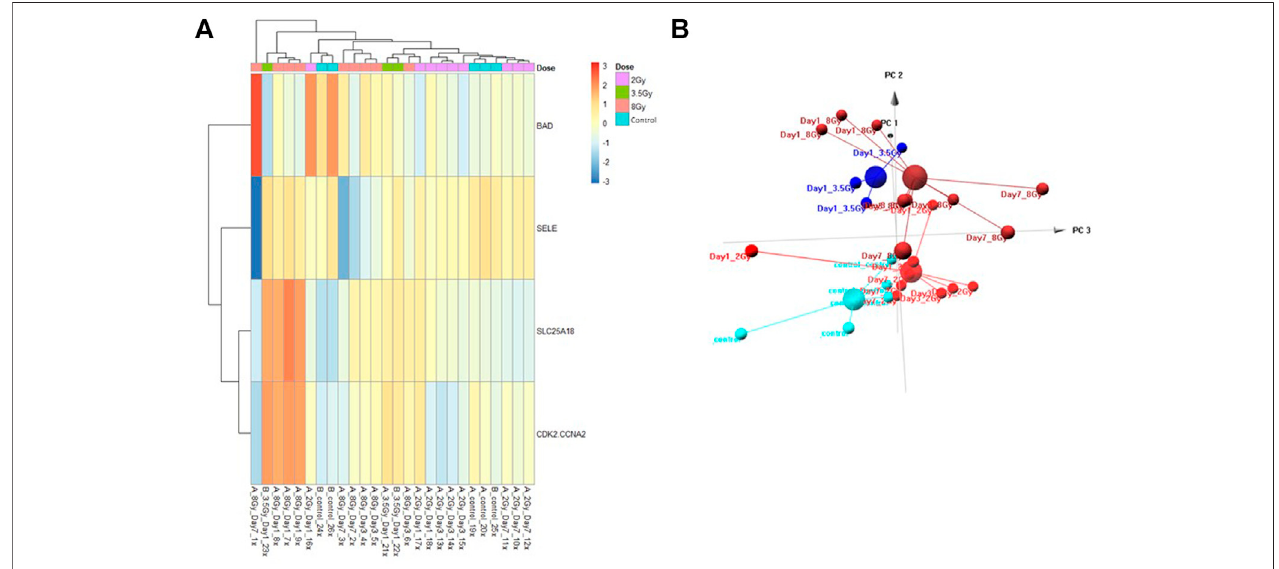
FIGURE 5 | Control vs. Dose Test Model. Analysis of proteomic expression within the sample cohort used for testing of the Control vs. Dose Test model using top selected proteins SL25A18, CDK2/CCNA2, SELE, and BAD. Findings are represented by (A) heatmap and (B) PCA.